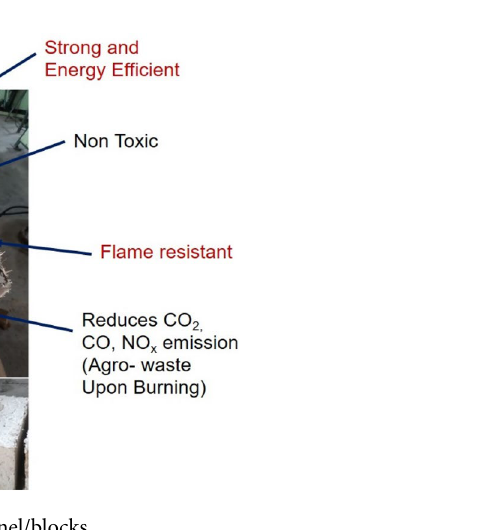
Figure 3. Features of agro-waste gypsum